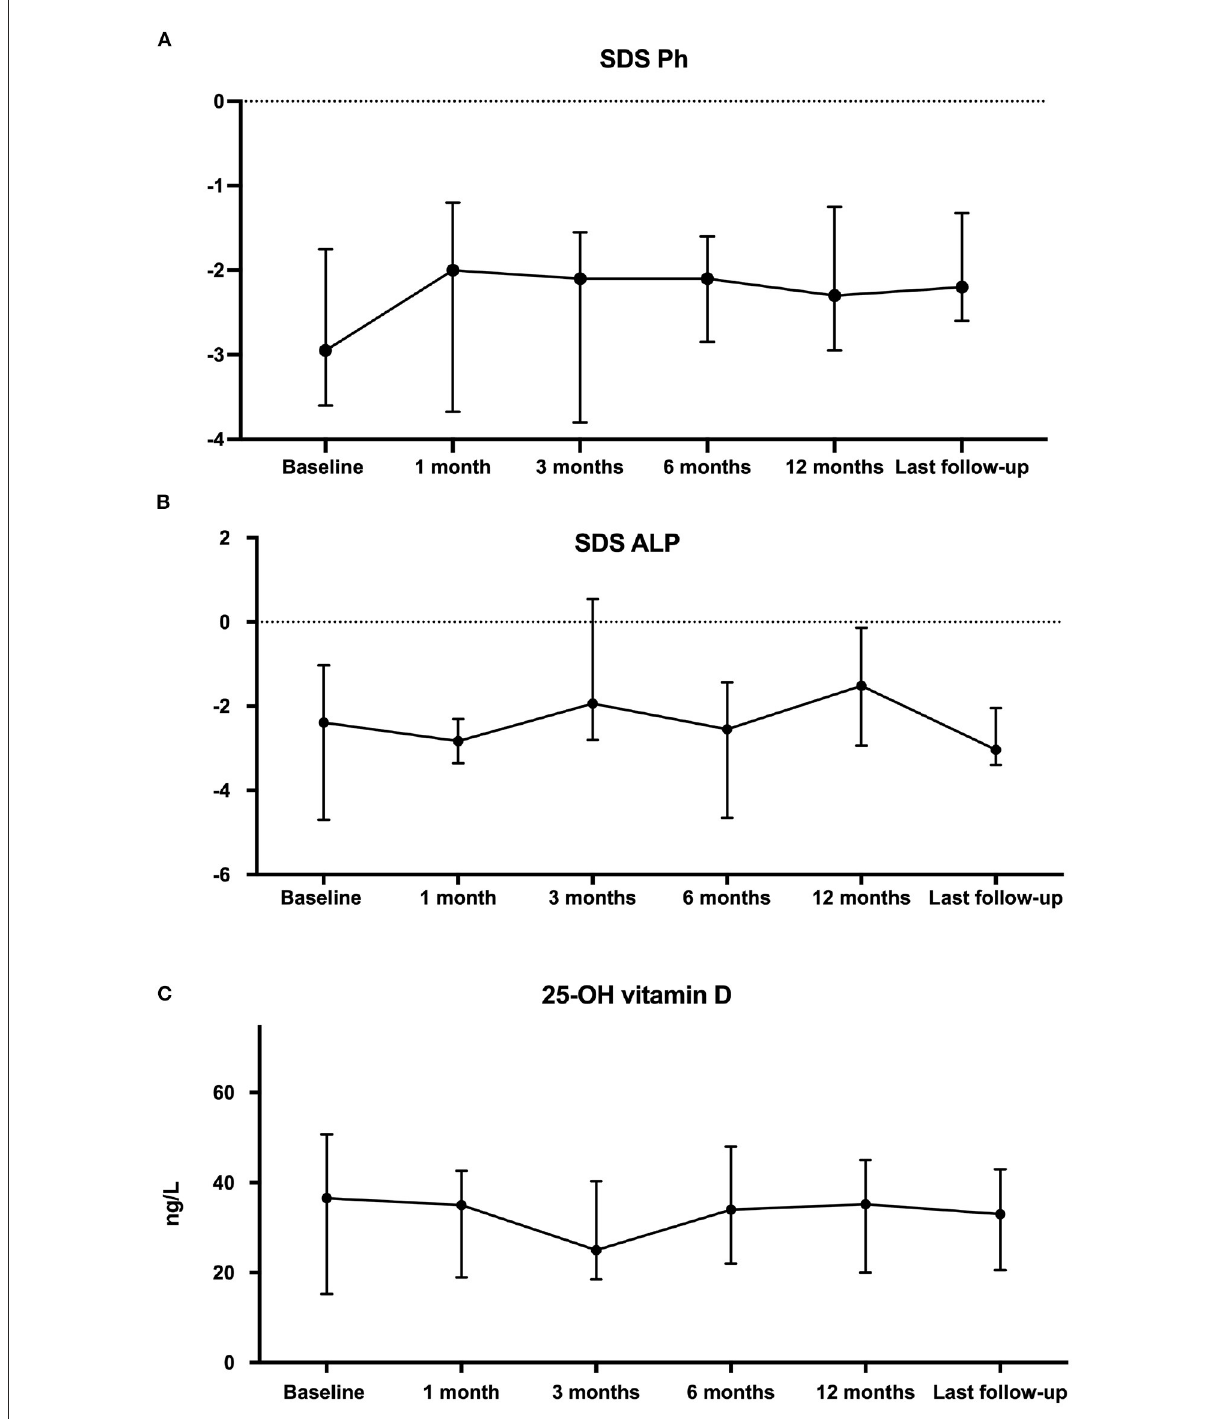
FIGURE3 Comparison of phosphate levels as z-score for age (A) , z-score for age alkaline phosphatases (B) and 25-OH vitamin D (C) data at cinacalcet initiation and during follow-up. Each dot on the graph represents median with interquartile range of biological data at the different time-points. Statistical analyses were performed with Kruskall–Wallis test: p = not statistically significant